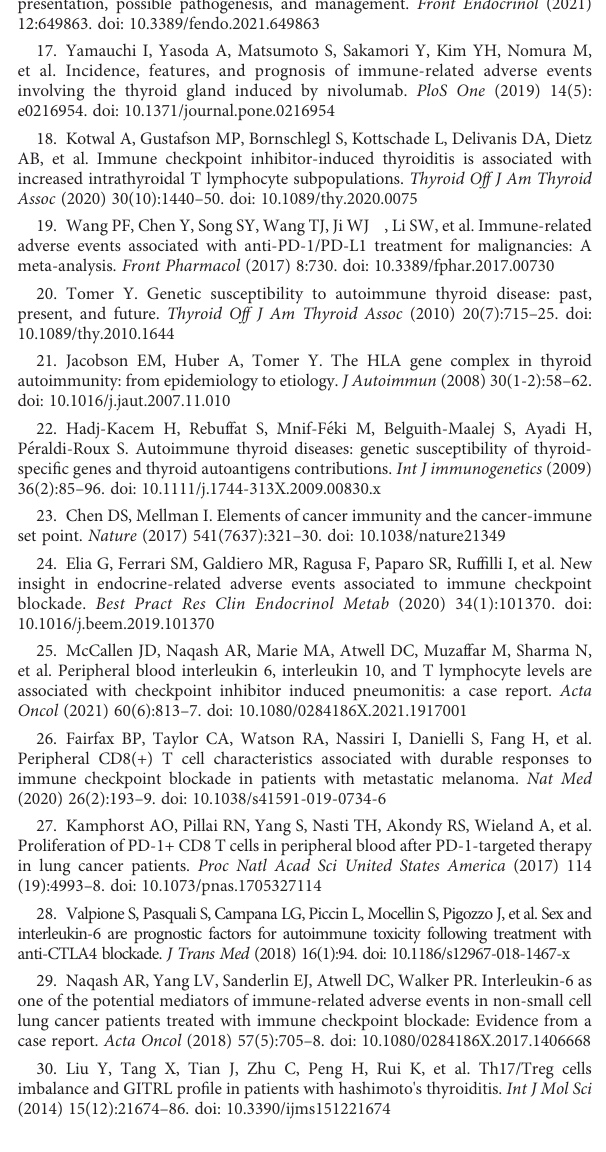
SUPPLEMENTARY FIGURE 1 Levels of thyroid stimulating hormone (TSH), neutrophil to lymphocyte ratio (NLR), and C-reactive protein (CRP) in the lung cancer patients treated with Nivolumab.Bloodsampleswerecollectedatthebaselineandaftereachcycle of Nivolumab treatment during the biomarker trial. (A&B) TSH levels (mIU/L), (C&D) CRP levels (mg/L), and (E&F) NLR levels, in patient #1 and #2, respectively. Onset of checkpoint inhibitor-induced thyroid dysfunction (CITD) is indicated by arrows on the graphs. SUPPLEMENTARY FIGURE 2 Radiographic imaging of patient #2 during the event of intestinal perforation. (A) TheanteroposteriorchestX-rayimageshowsfreeairunderthediaphragm and elevation of hemidiaphragm on the right side. (B) The lateral chest X-ray image shows free air below the diaphragm (red